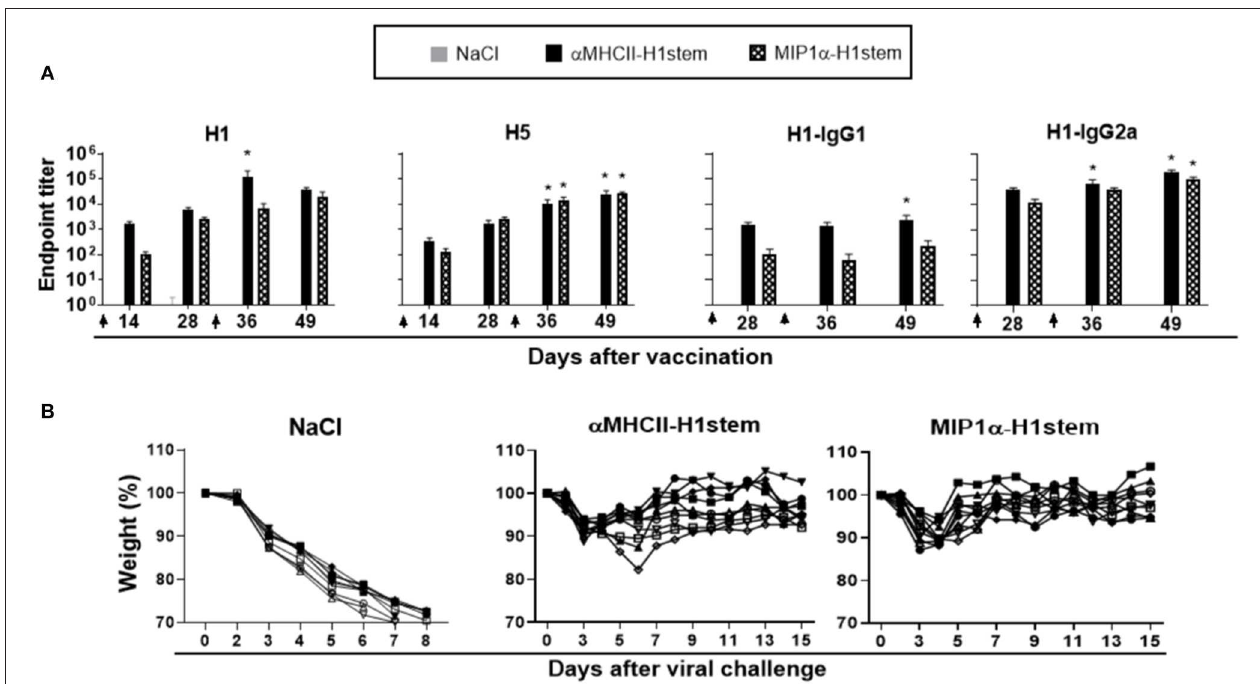
FIGURE 3 | Antibodies and protective efficacy after vaccination with α MHCII-H1stem and MIP1 α -H1stem. BALB/c mice ( n = 10 mice/group) were DNA-immunized twice on days 0 and 29, as indicated by arrows. (A) Sera were analyzed for development of total IgG responses against recombinant HA from PR8 and A/Hong Kong/483/97 (H5N1) and IgG1/IgG2a against HA from PR8. Values given are mean ± SEM. * p < 0.05 as compared to NaCl (two-way ANOVA and Bonferroni post-test). (B) 4 weeks after the final vaccination, mice were challenged with a 5 × LD50 dose of influenza PR8 and monitored for weight